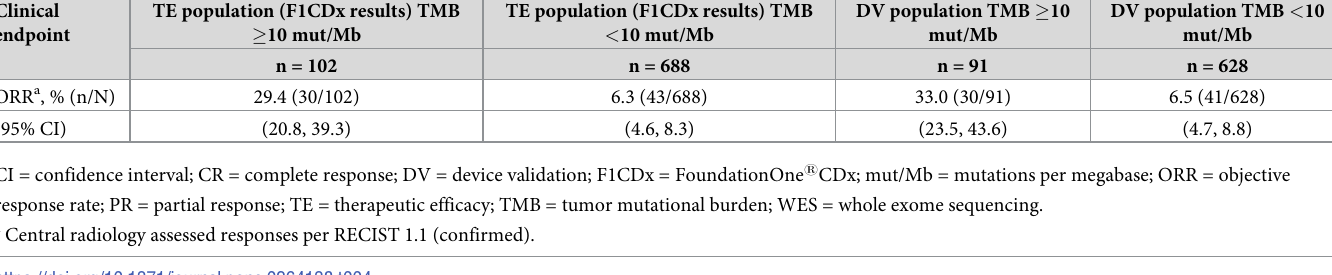
Table 4. Clinical utility of F1CDx for determining TMB-H status ( � 10 mut/Mb) in solid tumors in the efficacy analysis population. Clinical efficacy of pembrolizumab